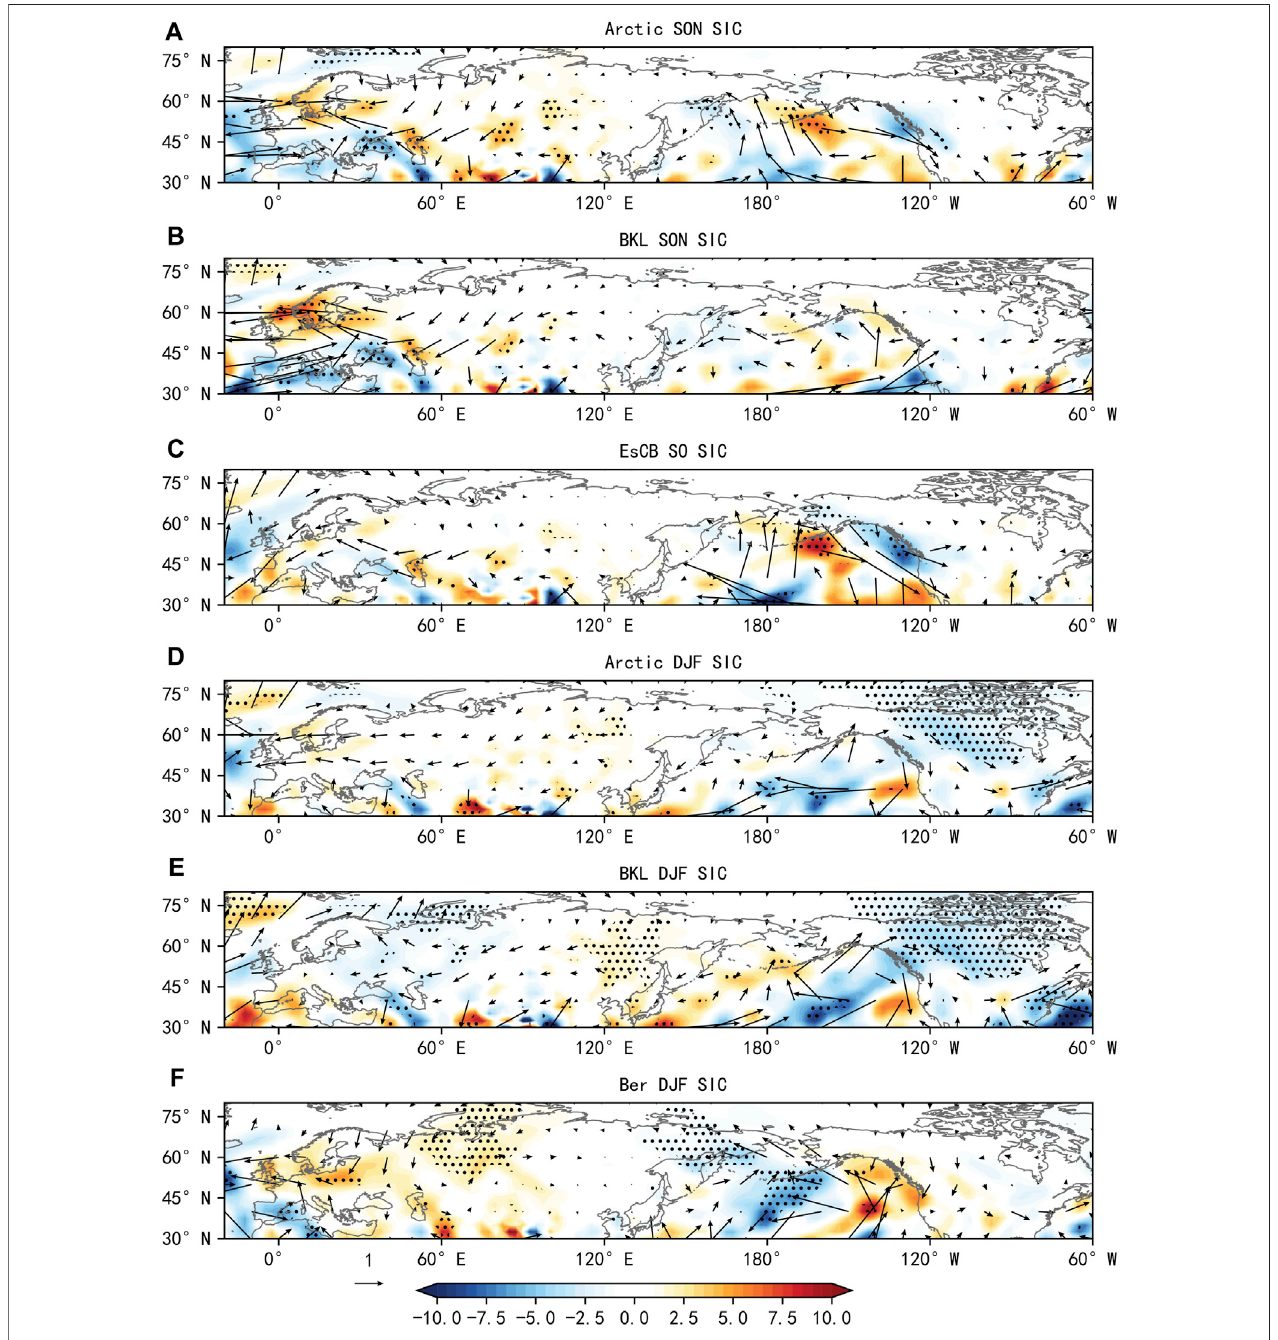
FIGURE 7 | As in Figure 6 but for 1,000 – 500-hPa cumulative moisture transport fl uxes [vectors; units: g (m s) − 1 ] and associated divergence [shading; units: g (m 2 s) − 1 ].